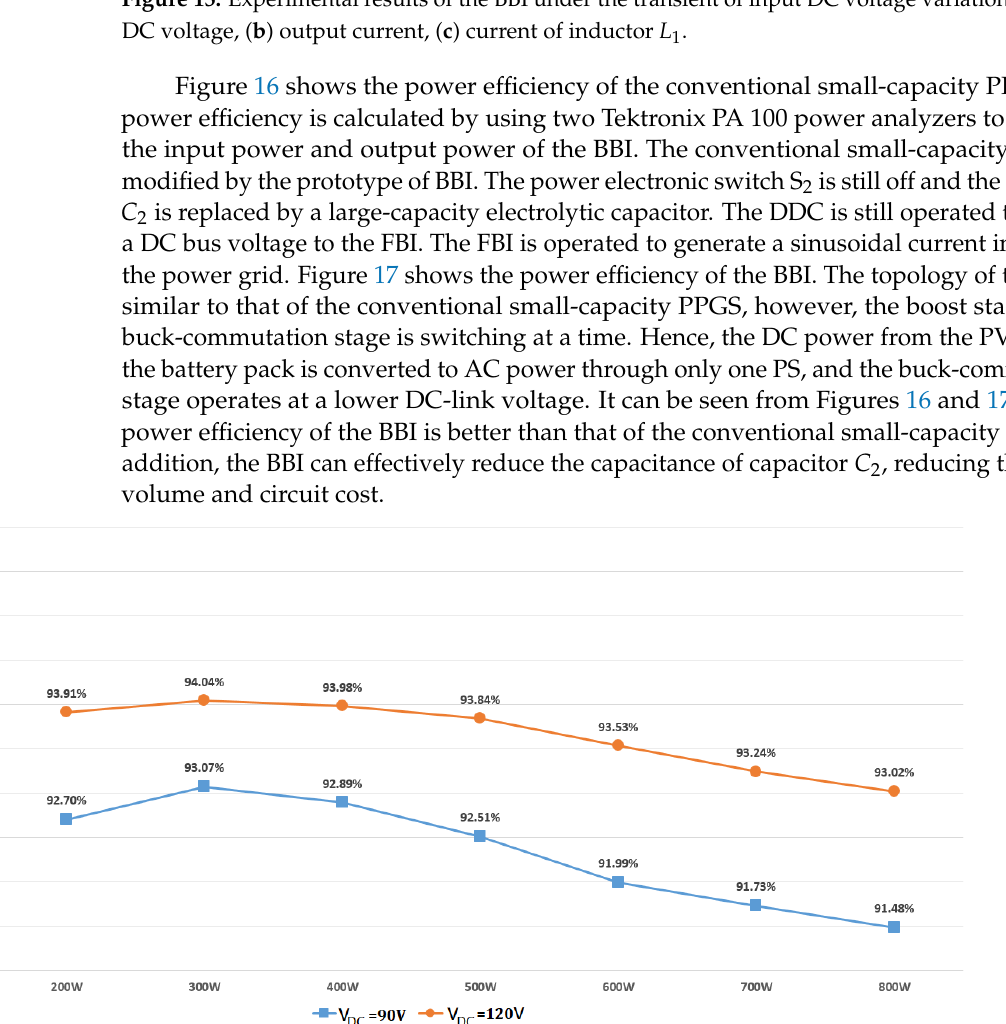
Figure 16. Power efficiency of the conventional small-capacity PPGS.